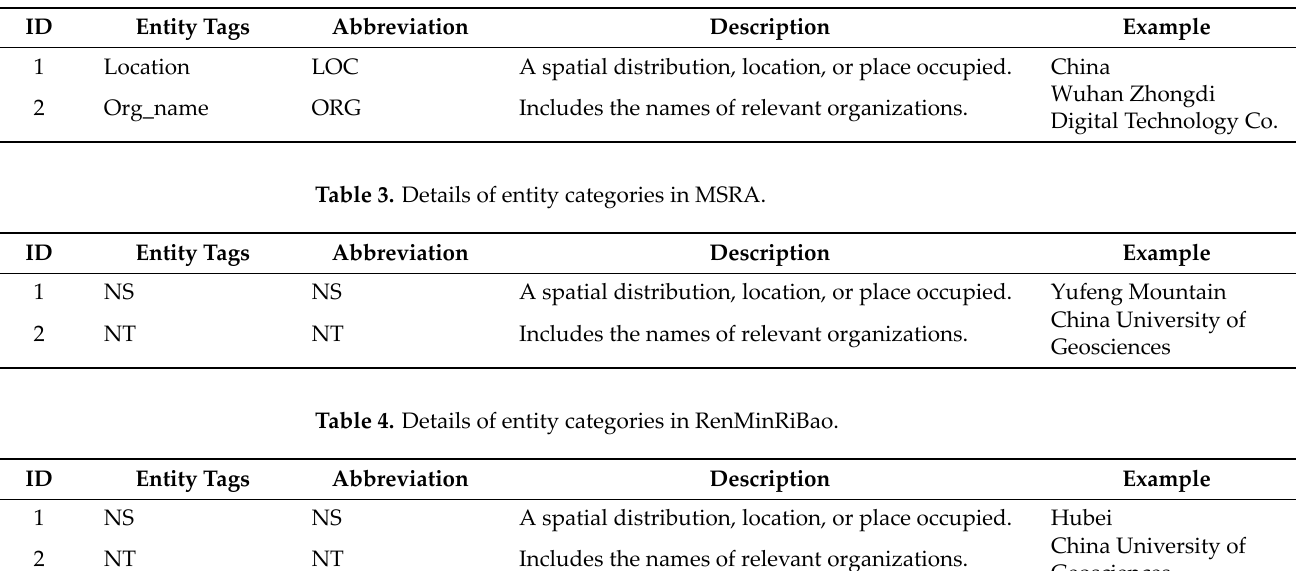
Table 2. Details of entity categories in Boson.